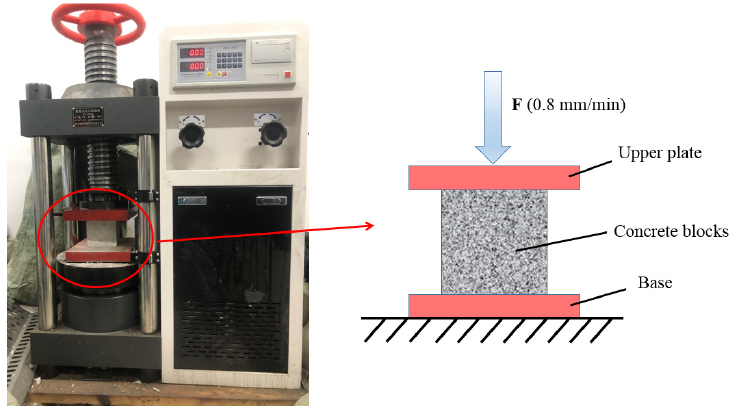
6 of 13 Figure 3. Concrete block-making process.